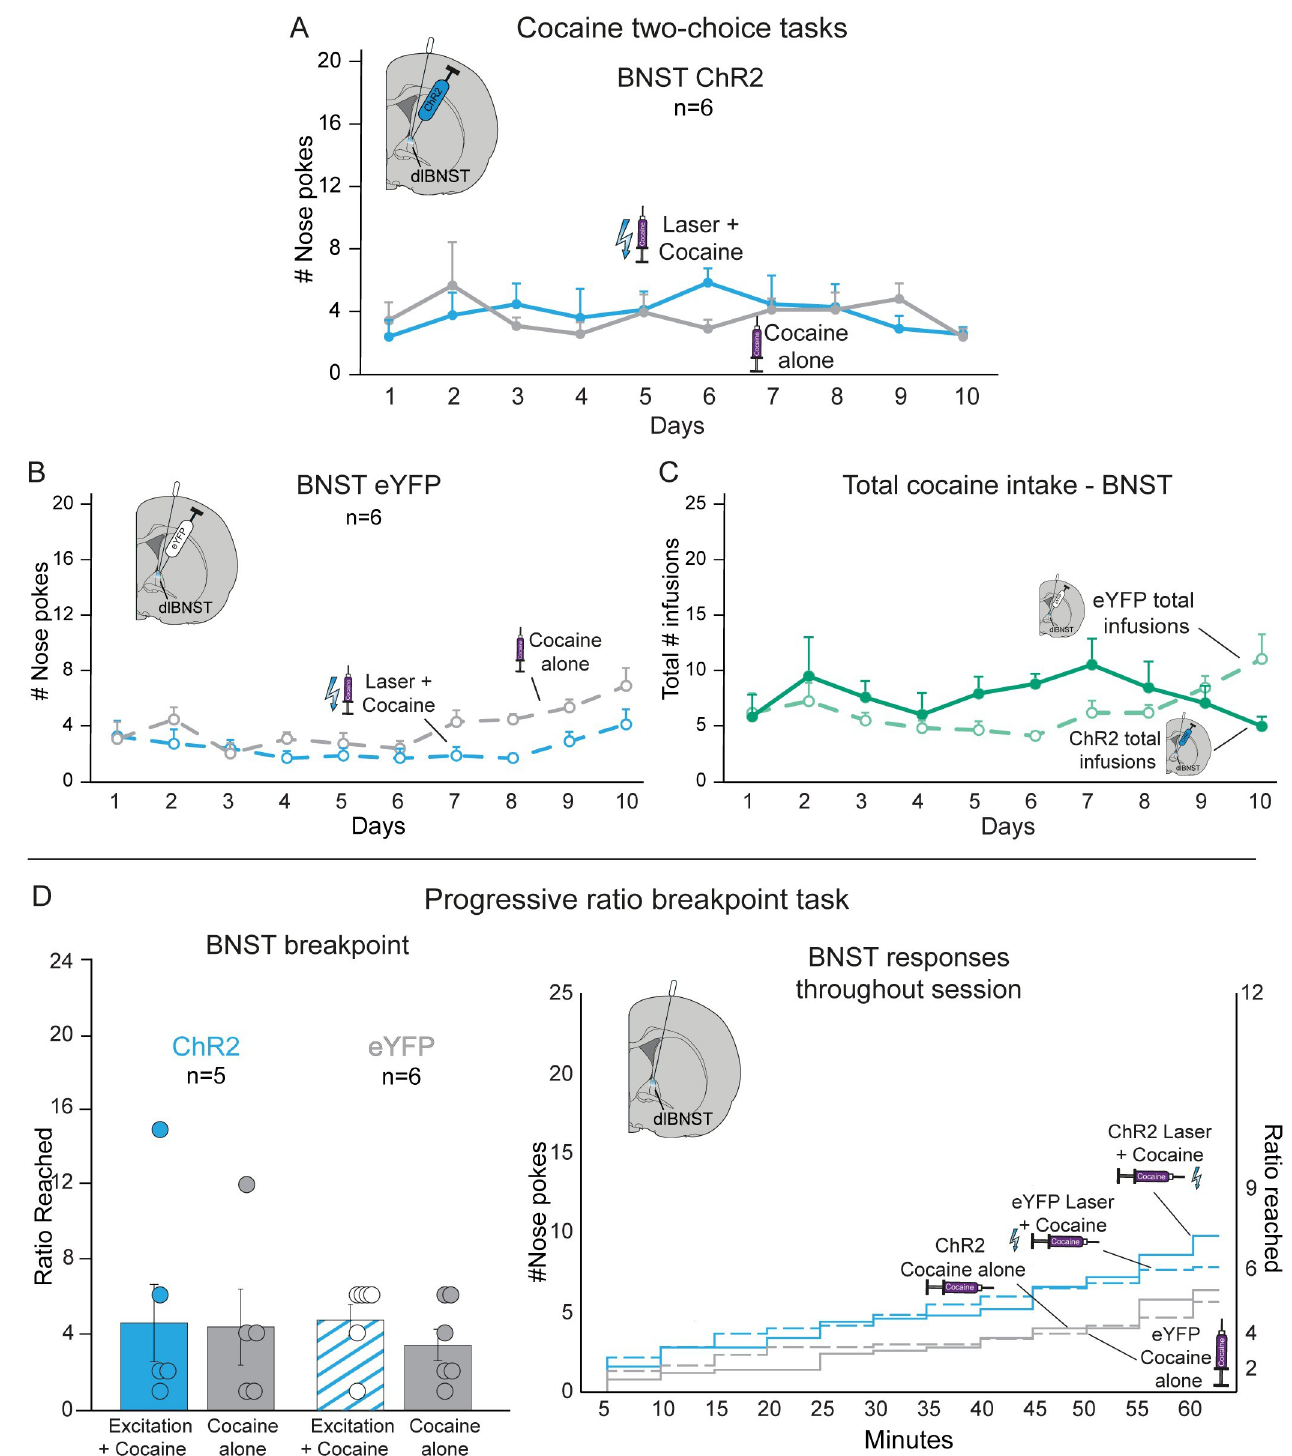
Fig 6. BNST ChR2 stimulation of CRF-containing neurons fails to change cocaine pursuit. Pairing ChR2 excitation of CRF neurons in BNST with one cocaine option failed to alter cocaine pursuit in the two-choice task for A) BNST ChR2 rats (n = 6); or B) BNST eYFP inactive control rats, (n = 6). C) BNST ChR2 stimulation had little no effect on total cocaine consumption in the two-choice task compared to eYFP controls plus Cocaine alone infusions). D) In progressive ratio (PR) tests, CRF-containing neuronal excitation failed to alter effort breakpoint of BNST ChR2 rats (n = 5; left panel), which remained similar also to the unchanging breakpoint of BNST eYFP control rats (n = 6). Right panel depicts timeframe of behavioral responses for cocaine during the 1hr PR sessions. Means and SEM reported. https://doi.org/10.1371/journal.pone.0267345.g006 PLOS ONE | https://doi.org/10.1371/journal.pone.0267345 May 3,